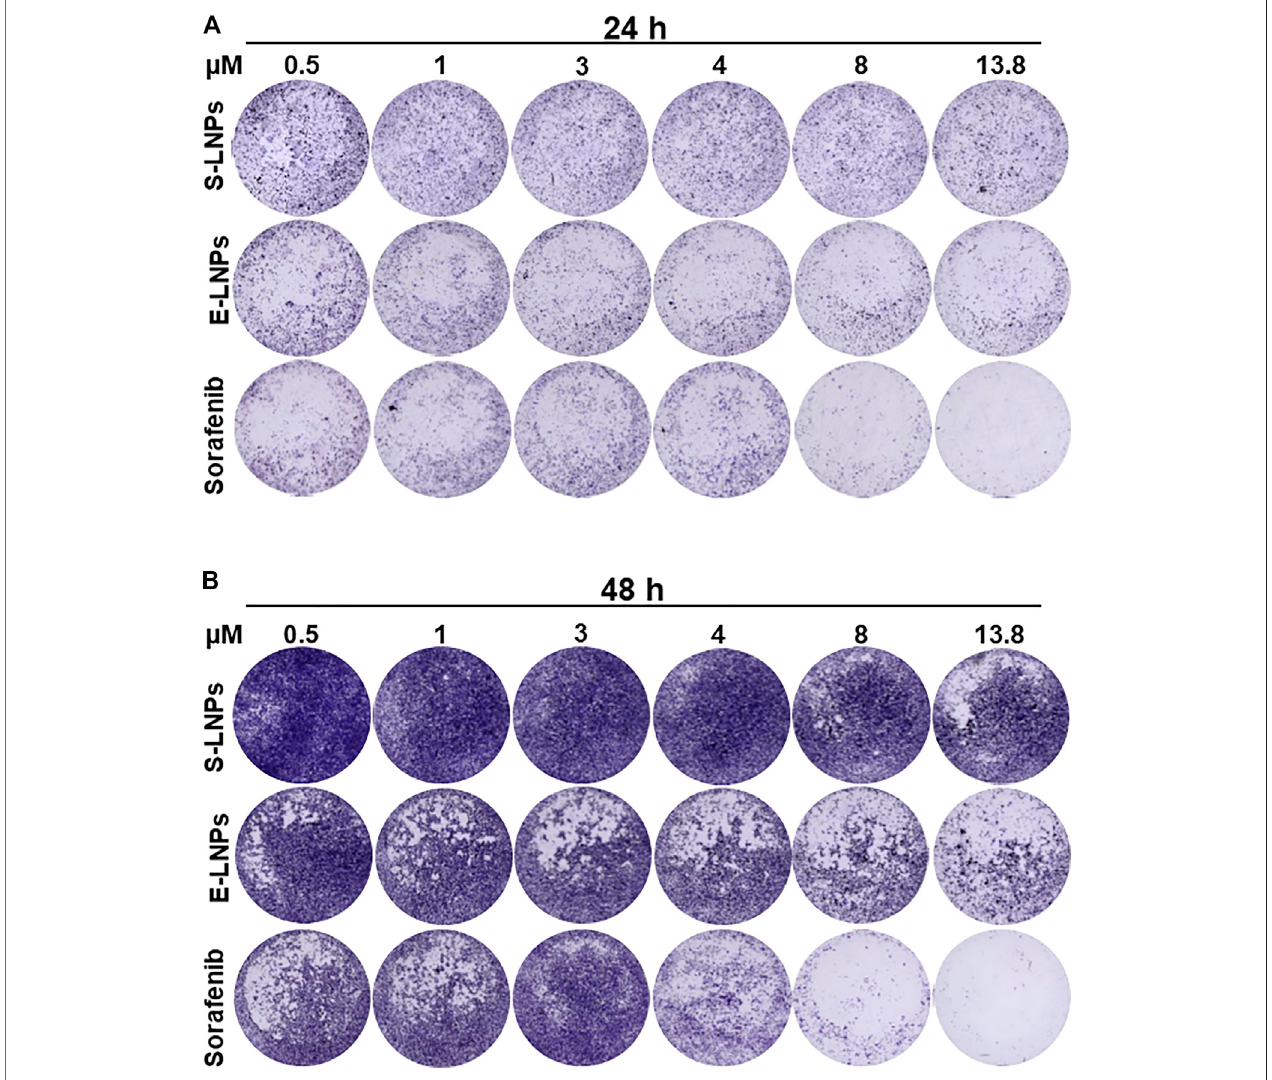
FIGURE 6 | LNPs inhibited the growth of HCC in a dose-dependent manner. CVSA was performed in HCC cells after the treatment with S-LNPs and E-LNPs at differentconcentrations:0.5,1,3,4,8,and13.8 µM.Standardmedicinesorafenibwasusedasapositivecontrol.Furthercontrolsareshownin SupplementaryFigure S7A . CVSA readouts were performed (A) 24 h and (B) 48 h post-incubation, respectively. For the direct comparison to a standard therapy, the sorafenib dose of 13.8 µm [plasma concentration, as reported for clinic (Fucile et al., 2015)] has been used as a positive control.